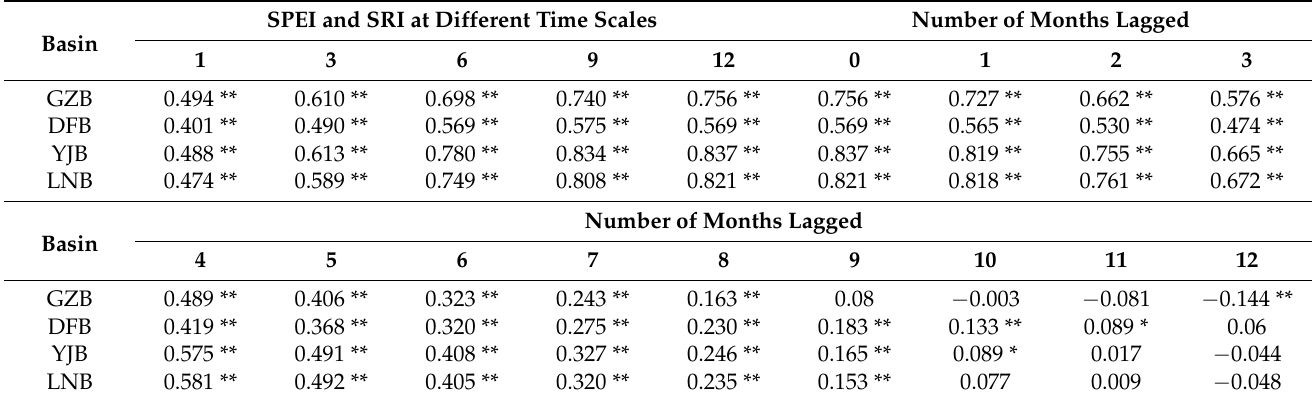
Table 3. Correlation between the SPEI and SRI at different time scales and meteorological-hydrological lag time correlation in the